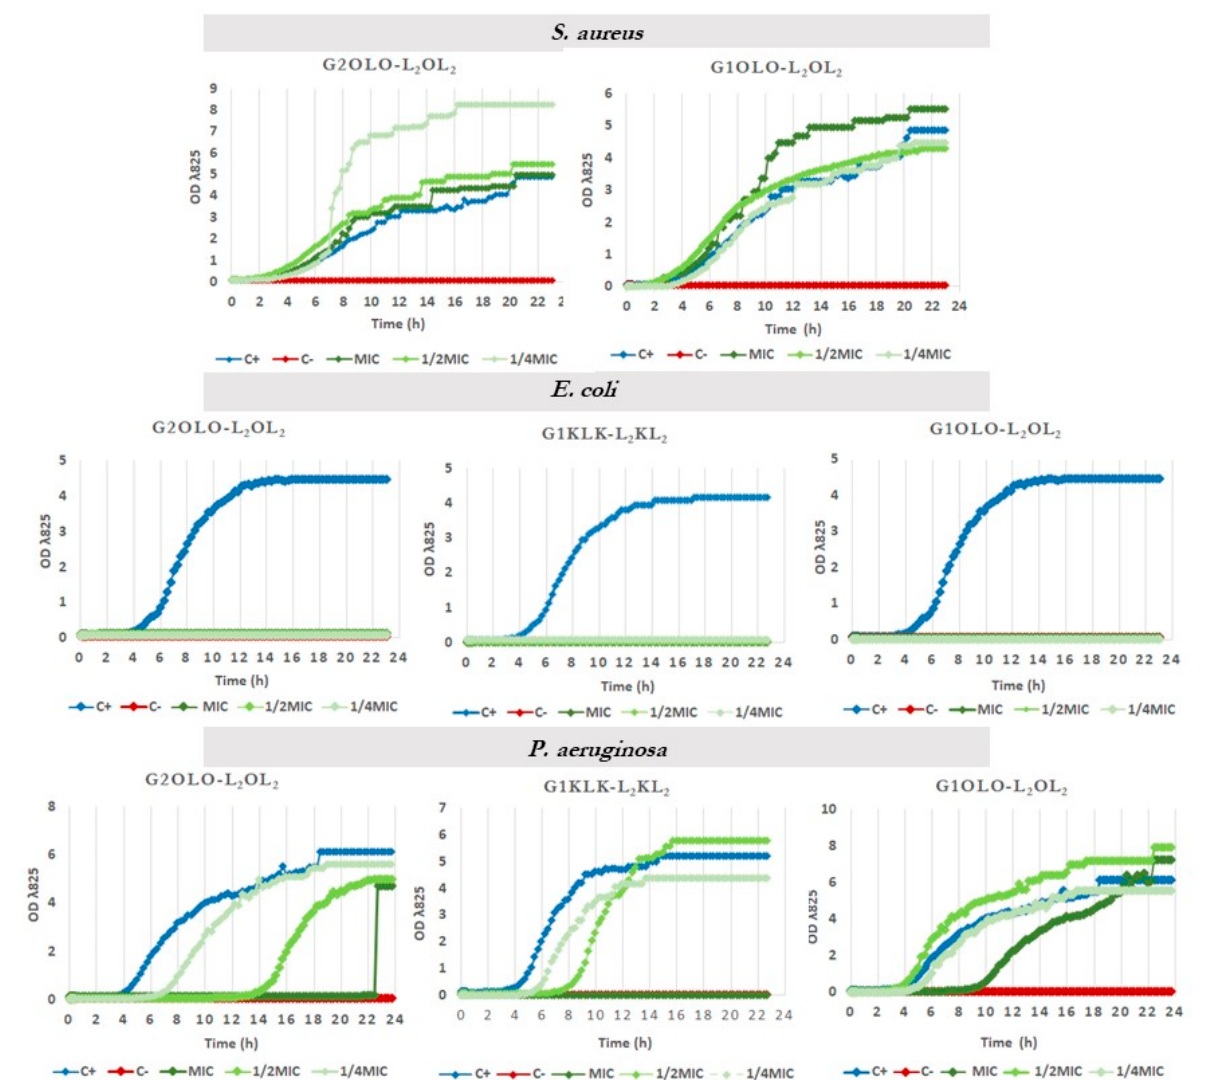
Figure 7. Growth curves of S. aureus, E. coli and P aeruginosa in the presence of MIC, ½ MIC and ¼ MIC of G2OLO-L 2 OL 2 and G1OLO-L 2 OL 2 .